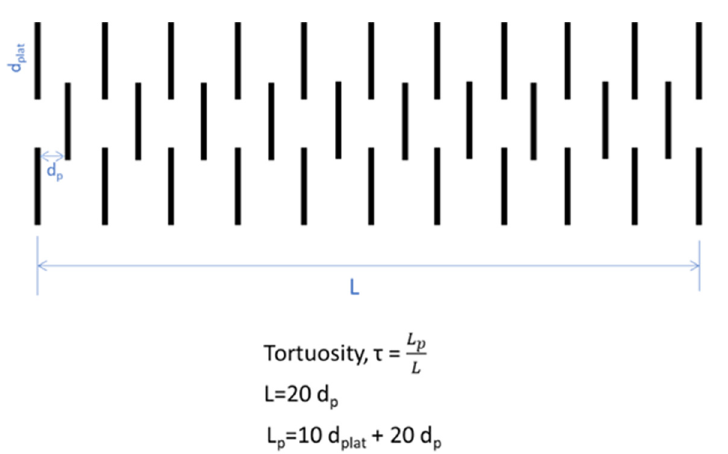
Figure 1. Basic configuration of GNPs to derive the relation for the tortuosity as a function of the geometrical features of the GNP configuration.